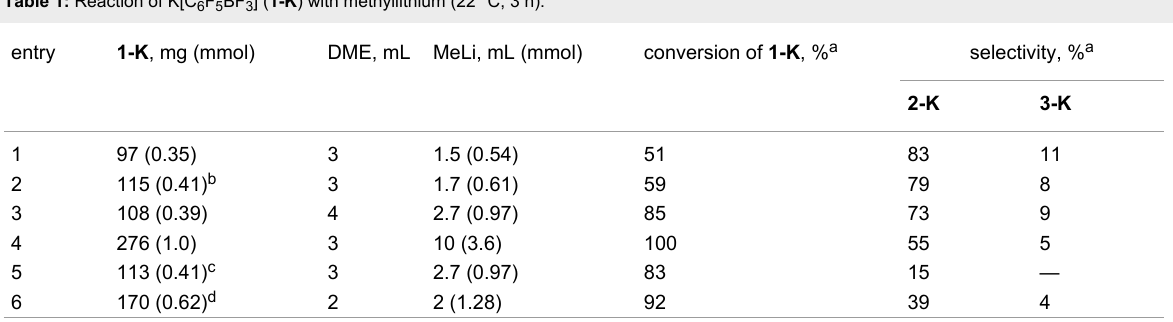
a from 19 F NMR data; b duration 6 h; c at 43–47 °C. Reaction mixture contained C 6 F 5 H (0.03 mmol, selectivity 9%) and 2,3,5,6-tetrafluorotoluene ( 4 ) (0.05 mmol, selectivity 15%) and minor unknown components; d reaction mixture was refluxed for 5 h (53–55 °C, bath); the filtrate contained unknown minor products besides the borates 1-K , 2-K , and 3-K .